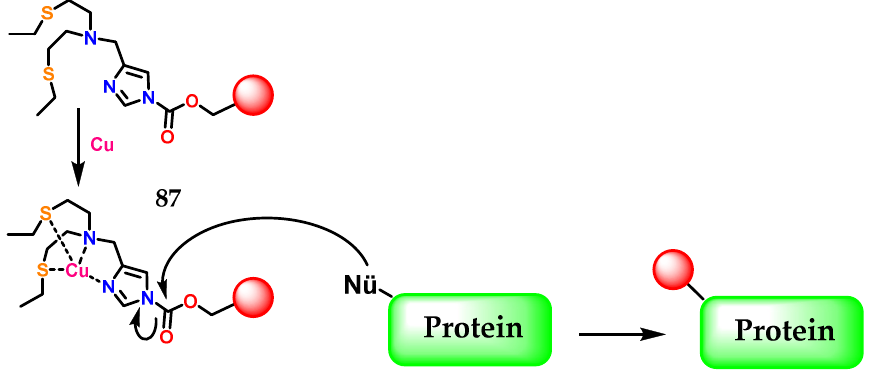
Figure 35. The activity-based sensing (ABS) strategy using acyl imidazole electrophiles 87 for subsequent labeling of proximal proteins at sites of high labile copper.